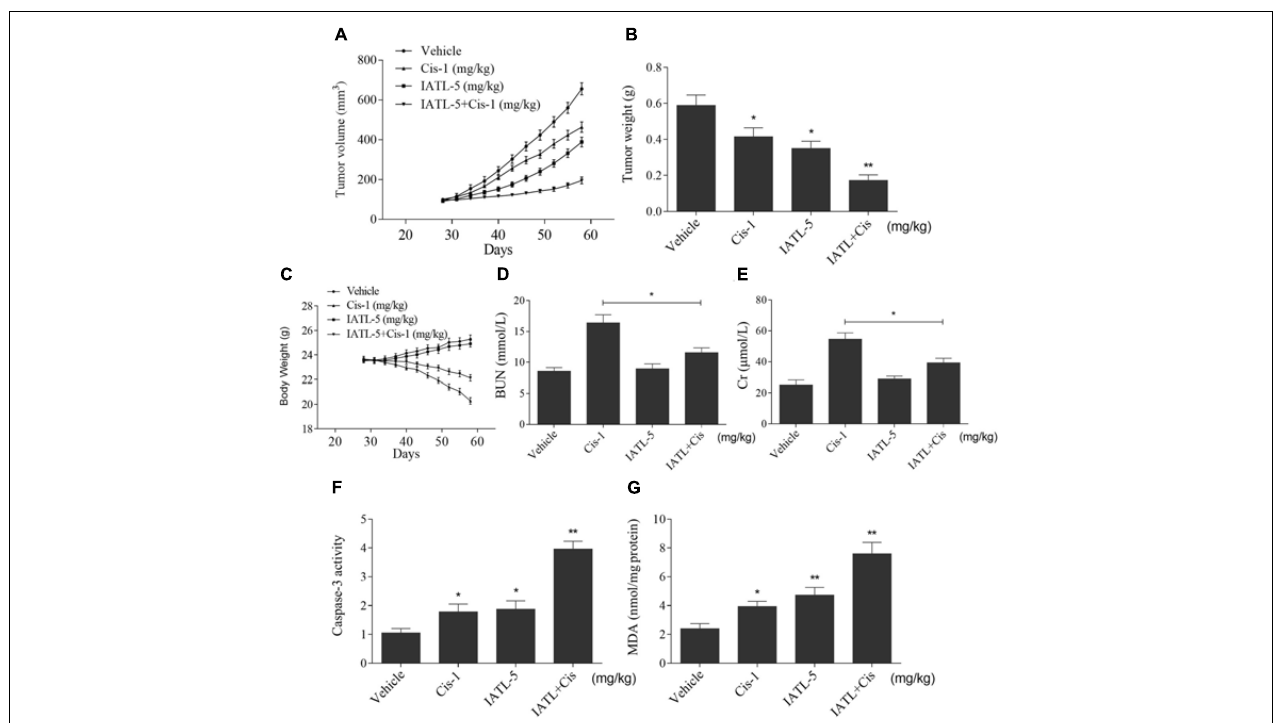
FIGURE 6 | IATL and cisplatin synergistically inhibit tumor growth in nude mice. (A,B) IATL in combination with cisplatin markedly suppressed tumor volume (A) and tumor weight (B) . (C) The body weight of nude mice. (D,E) The levels of blood urea nitrogen (BUN) and creatinine (Cr). (F) Caspase-3 activity in the tumor tissues. (G) MDA levels in the tumor tissues. * p < 0.05, ** p < 0.01.